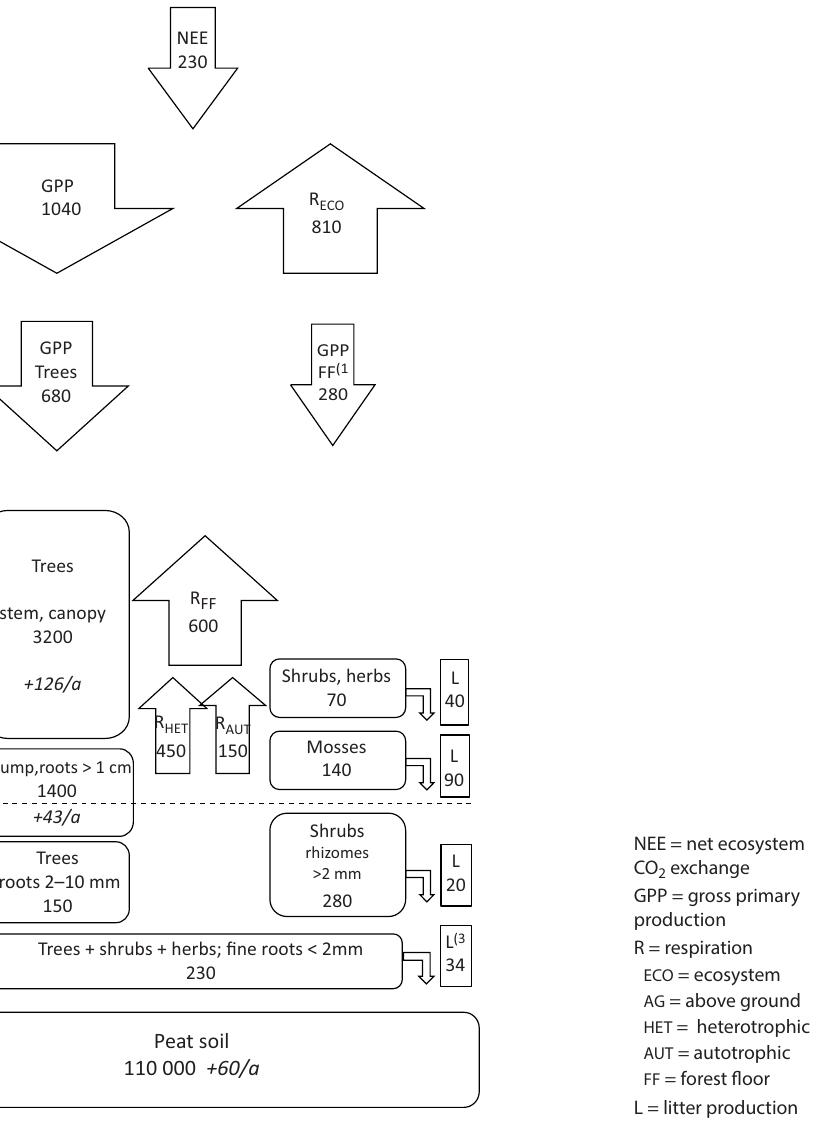
Figure 9. Measured carbon pools (rounded boxes; gCm − 2 , and the changes in pools in italics; gCm − 2 a − 1 ) and fluxes (arrows and square boxes; gCm − 2 a − 1 ) in Kalevansuo drained peatland. Soil C accumulation is calculated as NEE (230gCm − 2 a − 1 ) – C sequestration in tree stand biomass (170gCm − 2 a − 1 ; above- 126gCm − 2 a − 1 and below-ground 43gCm − 2 a − 1 ) . Other fluxes and pools are based on measured and modelled values derived from EC and chamber measurements, biomass measurements, and litterfall measurements in Kalevansuo. The tree stand biomass is from the autumn 2008 measurement. (1) Badorek et al., 2011; (2) fine root production of trees (Bhuiyan et al., 2016); (3) fine root production of shrubs and herbs (Bhuiyan et al.,